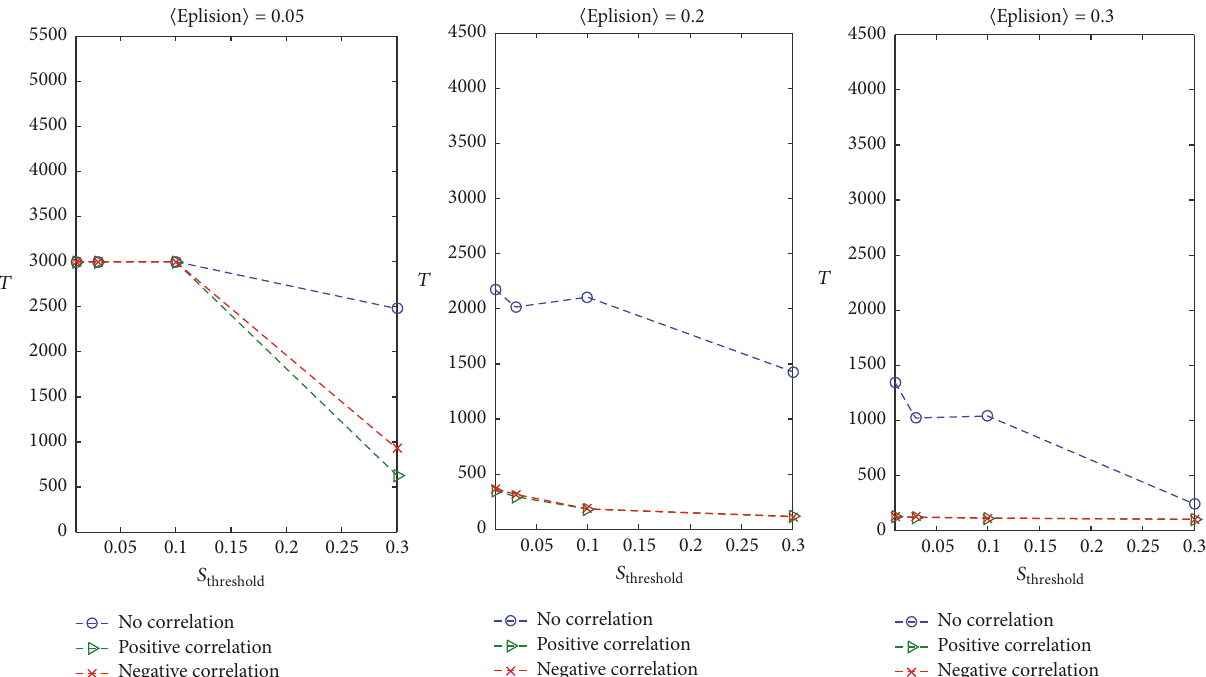
Figure 8: Comparison of 𝑇 (stable time) on the SSHK model under three correlation types of confidence bound and social similarity threshold, wherein 𝛼 = 3 . Every result is averaged 100